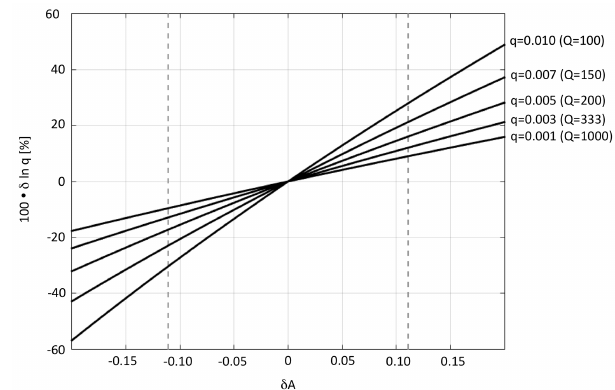
Figure 11. Fractional attenuation bias δ ln q induced by 3-D den- sity variations as a function of the relative amplitude difference δA . Dashed lines indicate the standard deviation of δA for the setup that we used previously to study the effect of epicentral distance (epi- central distance: 1000km, frequency band: 0 . 02–0 . 125Hz, lateral correlation length: 200km, vertical correlation length: 20km; see Sect. 3.3). The corresponding histograms are shown in Fig.